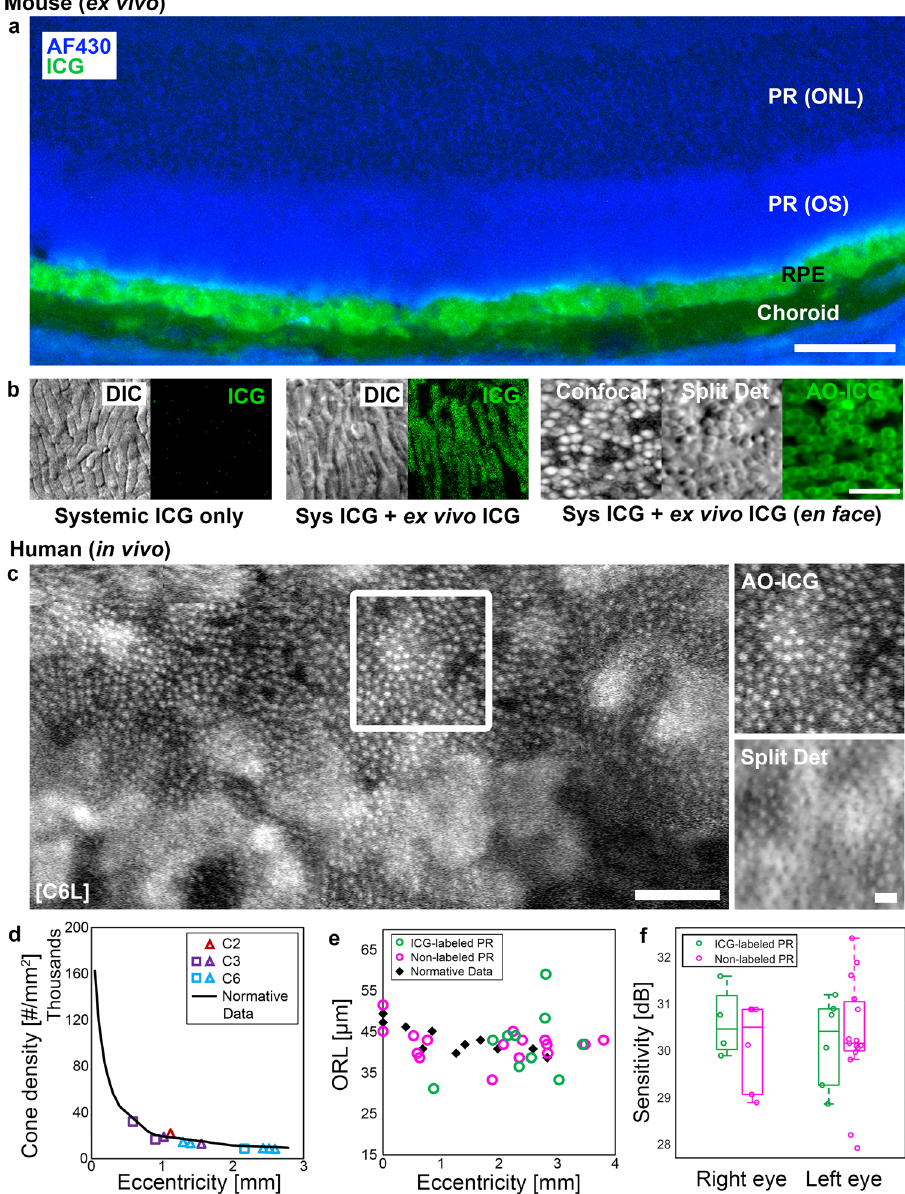
Fig. 4 ICG labeled photoreceptors in mice and human. a Following intraperitoneal injection of ICG in mice, ICG can be detected within the RPE in un fi xed cryosections, as has been previously demonstrated 34 . The overlying photoreceptors (PR) remain unlabeled under normal conditions due to the tight junction between RPE cells, which together establish the outer blood retinal barrier. The PR outer segments (OS) and outer nuclear layer (ONL) can be discerned using auto fl uorescence imaging (430 nm). A faint infrared auto fl uorescence can be observed in the choroid due to melanin. Scale bar, 50 µ m. b No detectable ICG signal was observed in the photoreceptor layer after systemic injection of ICG. The presence of photoreceptor pro fi les was con fi rmed using differential interference contrast (DIC) microscopy. However, following an ex vivo incubation with ICG, the photoreceptors were readily labeled with ICG. These results were further corroborated using a custom-assembled adaptive optics microscope capable of simultaneous acquisition of en face confocal re fl ectance (displayed in log scale), non-confocal split detection, and AO-ICG images of the photoreceptor mosaic. Scale bar (all images in b ), 10 µ m. c ICG labeled photoreceptors observed in a female carrier. The heterogeneous RPE fl uorescence pattern can be observed in the background. Zooms of the white box show that the fl uorescently labeled photoreceptors are consistent with photoreceptors imaged using non-confocal split detection. Scale bars: 50 µ m (C6L larger image), 10 µ m (zooms, AO-ICG and Split Det). d The densities of cone photoreceptors in areas of ICG labeling are similar to normative histologic values 43 . e Outer retinal length (ORL) measurements were performed using AO-OCT images acquired in areas of ICG labeling and in areas without ICG labeling. There was no apparent difference in ORL between labeled or non- labeled photoreceptors, and both were similar to ORL measurements performed in healthy eyes. f Retinal sensitivity measurements (microperimetry) performed within patches of ICG labeled photoreceptors were within normal limits and similar to measurements obtained in neighboring, non-labeled